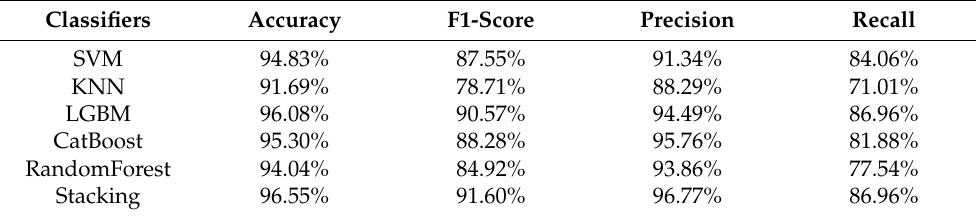
Table 1. CIC-AndMal2017 detection results.